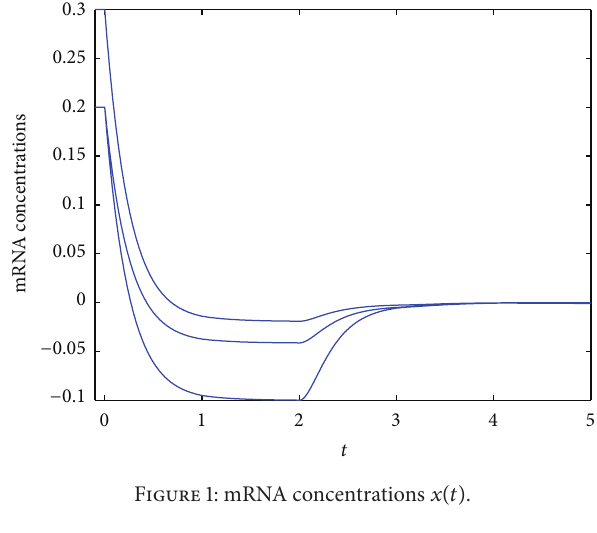
Figure 1: mRNA concentrations 𝑥(𝑡) .